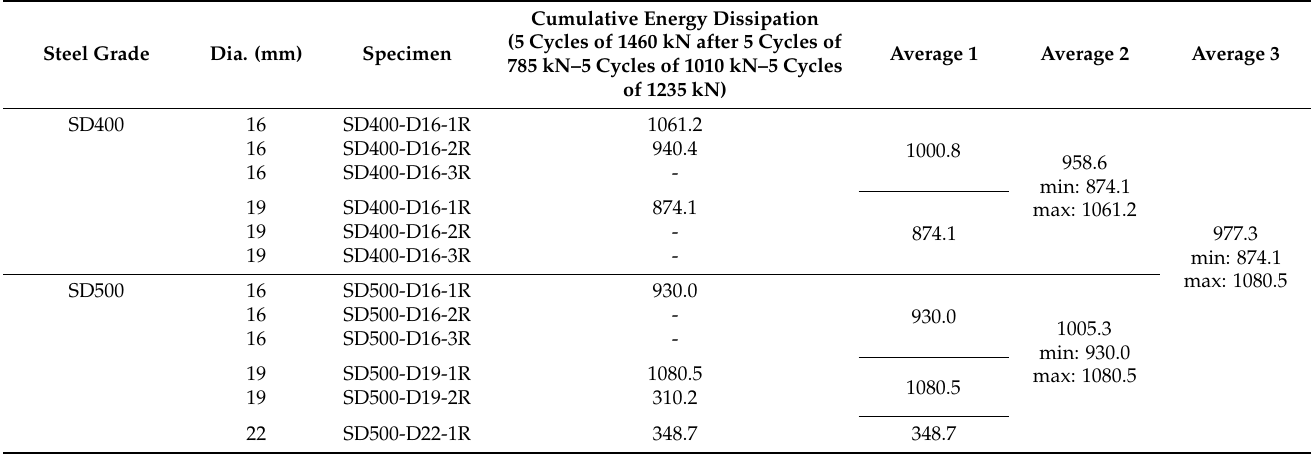
Table 16. Energy dissipation according to transverse rebar type (repeated load = 1460 kN) (unit = kN · mm).